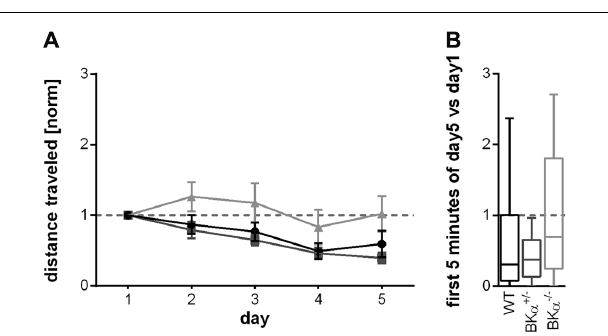
FIGURE 5 | Short-term habituation of open field locomotor activity. (A) Habituation of exploratory behavior was measured in a locomotor box. Within the 2 h test in the open field box all animals habituated to the environment, leading to a strong decline in locomotion. Figure shows average values and standard errors. (B) All genotypes had a similar habituation score of around 0.2 (displayed as median and whiskers